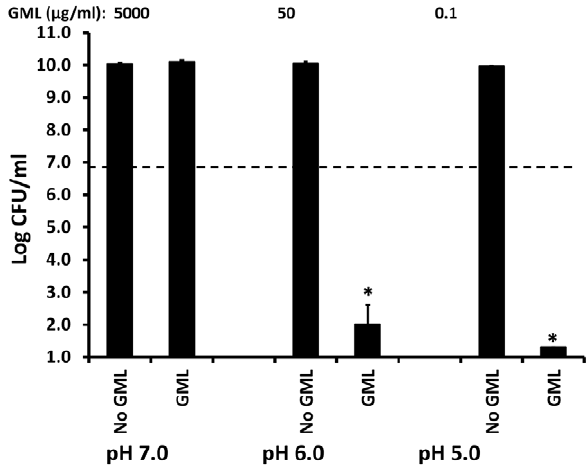
Figure 12. Effect of pH on GML activity against Escherichiacoli Watson strain. Todd Hewitt broth was buffered to pH 7.0, 6.0, and 5.0. Susceptibility of Escherichia coli to GML at the indicated pH was measured in 24 hour assays. CFUs/ml were determined by plate counts. * indicates means of No GML samples and GML samples differ significantly at p , 0.001. Dashed line indicates the inoculum size.